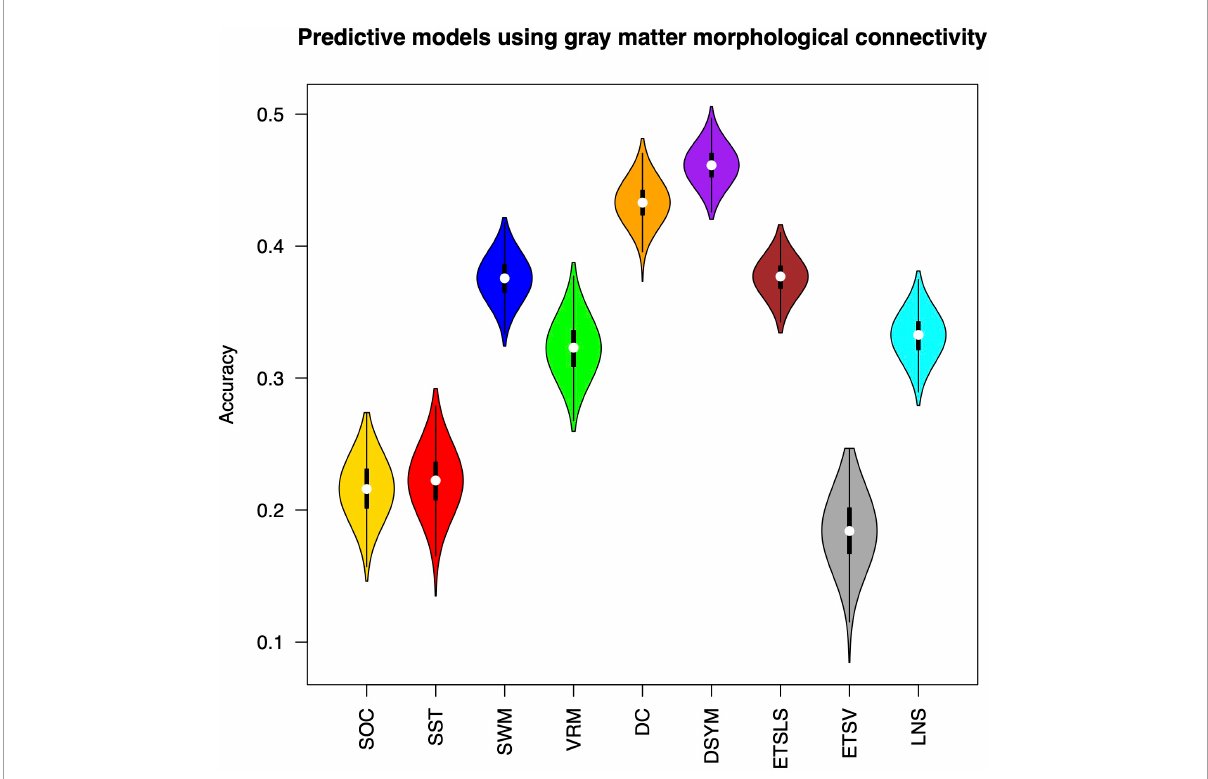
FIGURE3 Performance of the predictive models based on gray matter morphological connectivity. The nine cognitive predictive models contain the Stockings of Cambridge (SOC), the stop signal task (SST), the spatial working memory (SWM), the verbal recognition memory (VRM), the digit comparison (DC), the digit symbol (DSYM), the ETS advanced vocabulary (ETSV), the ETS letter sets (ETSLS), and letter number sequencing (LNS), respectively.